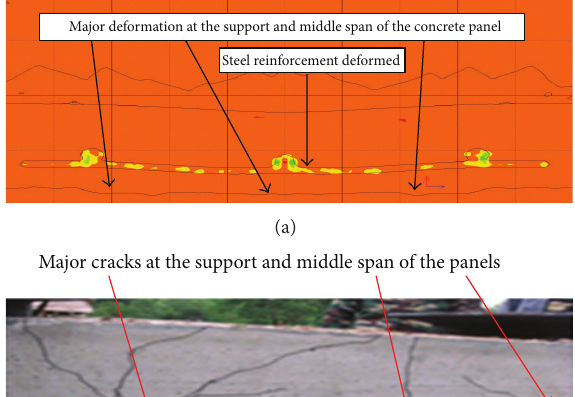
Figure 9: Peak overpressure resulted from 1 kg of plastic explosive at a distance of 300 mm.